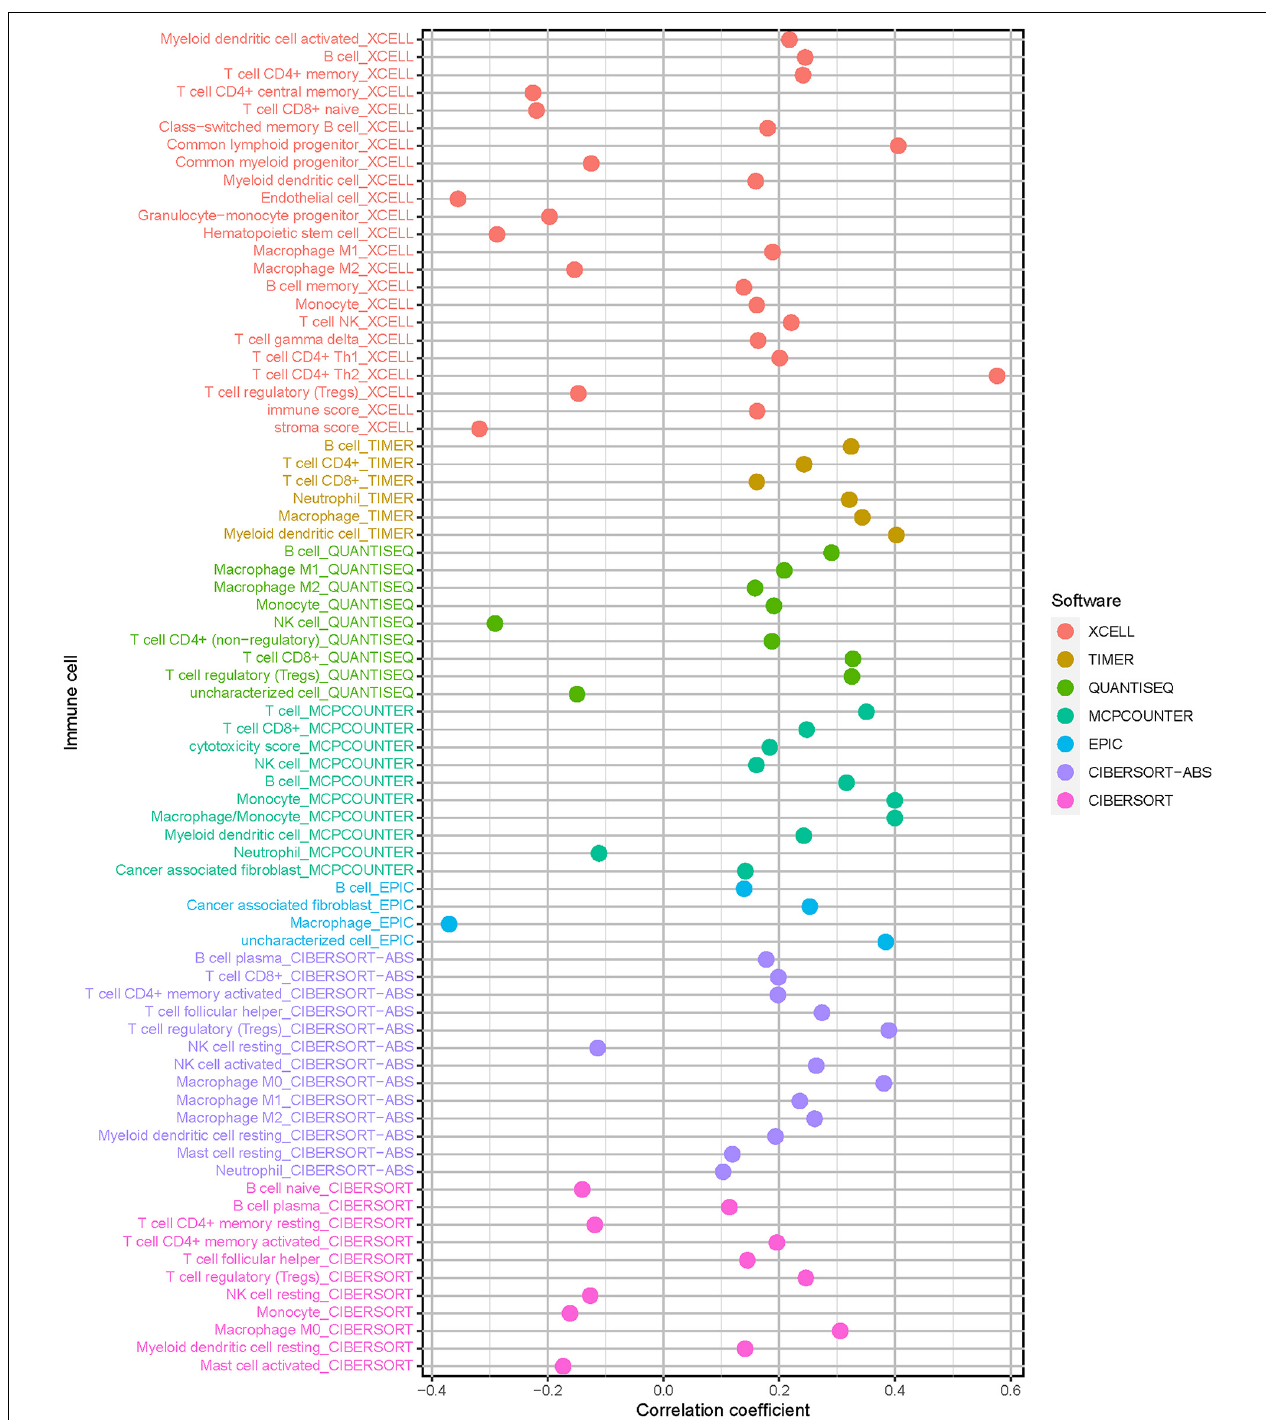
FIGURE 7 | Estimation of tumor-infiltrating cells. Patients in the high-risk group were more positively associated with cancer associated fibroblast, M2 macrophage, and T cell regulatory, whereas they were negatively associated with resting NK cells and resting memory CD4 + T cells, as shown by Spearman correlation analysis.